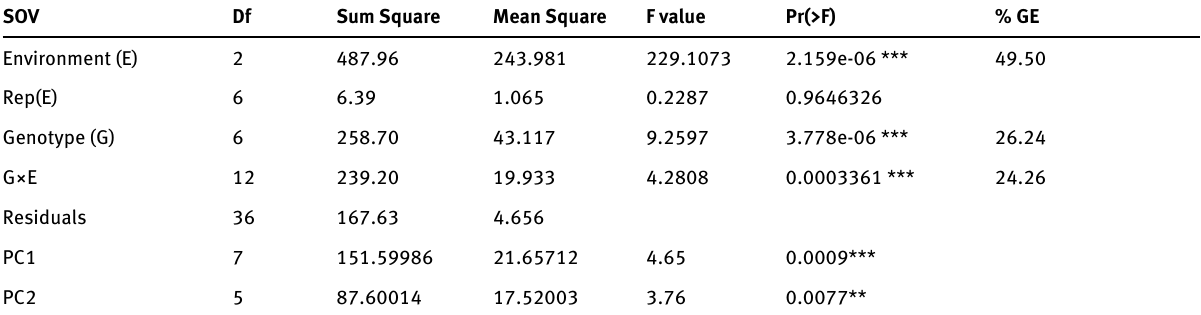
Table 2 : Combined analysis of variance of grain yield of barley genotype examined in three locations SOV Df Sum